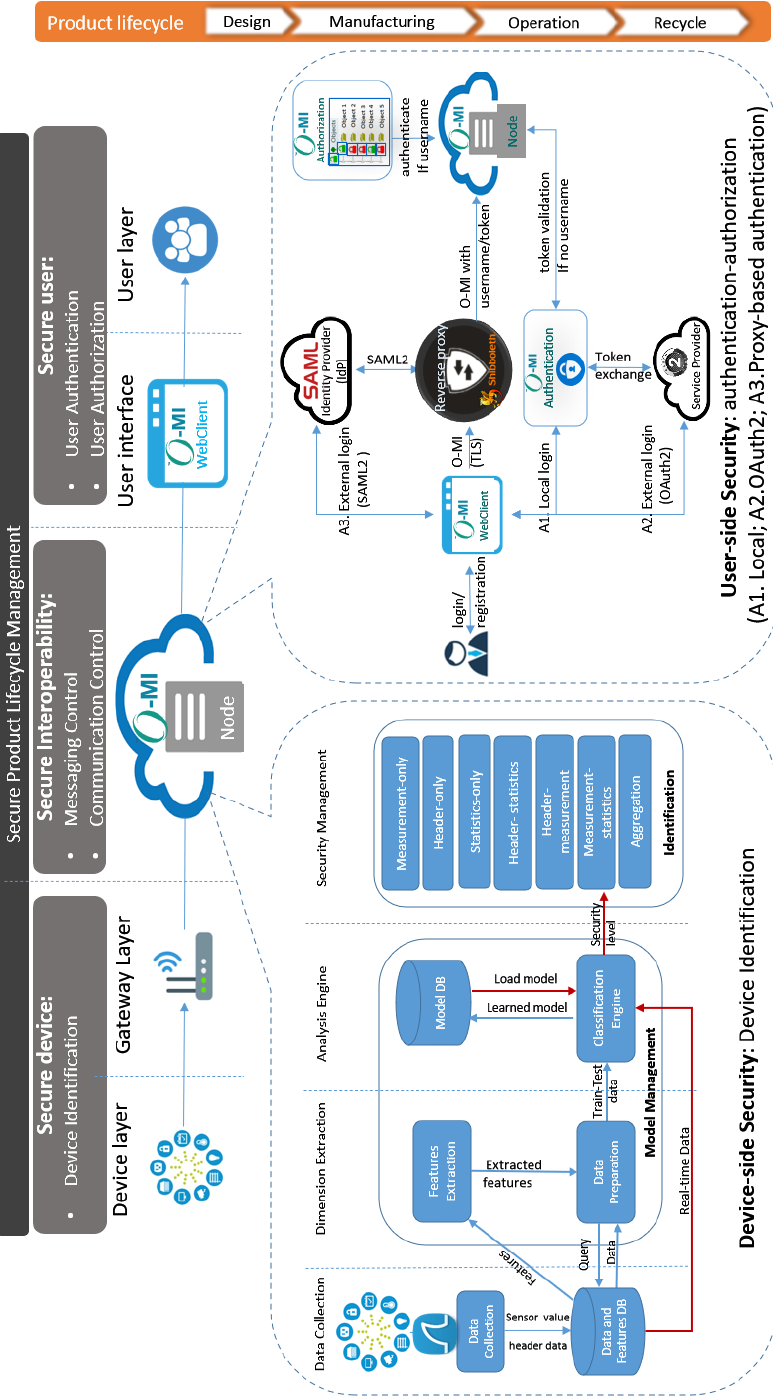
Figure 5. An overview of the security architecture over